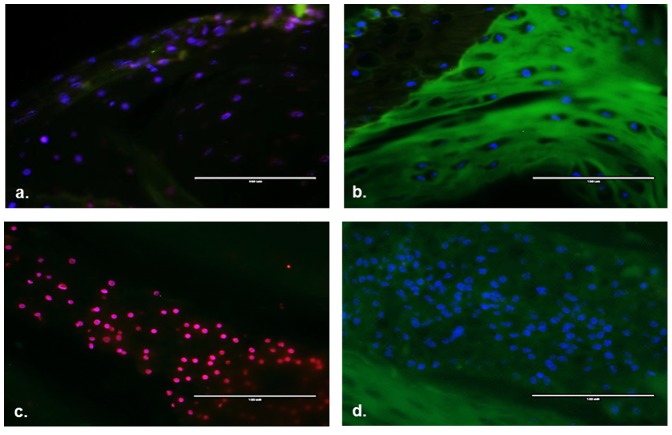
Cell viability in 14 day explant organ culture.Sections were stained with propidium iodide (red), Cell tracker green (green), and DAPI nuclear co-stain. Annulus fibrosus tissue section after treatment with 70% methanol (positive control) for 24 hours (a) and after 14 days of ex vivo organ culture (b). Nucleus pulposus tissue section after treatment with 70% methanol for 24 hours (c) and after 14 days of ex-vivo organ culture (d). Purple staining is indicative of PI and DAPI counterstaining.